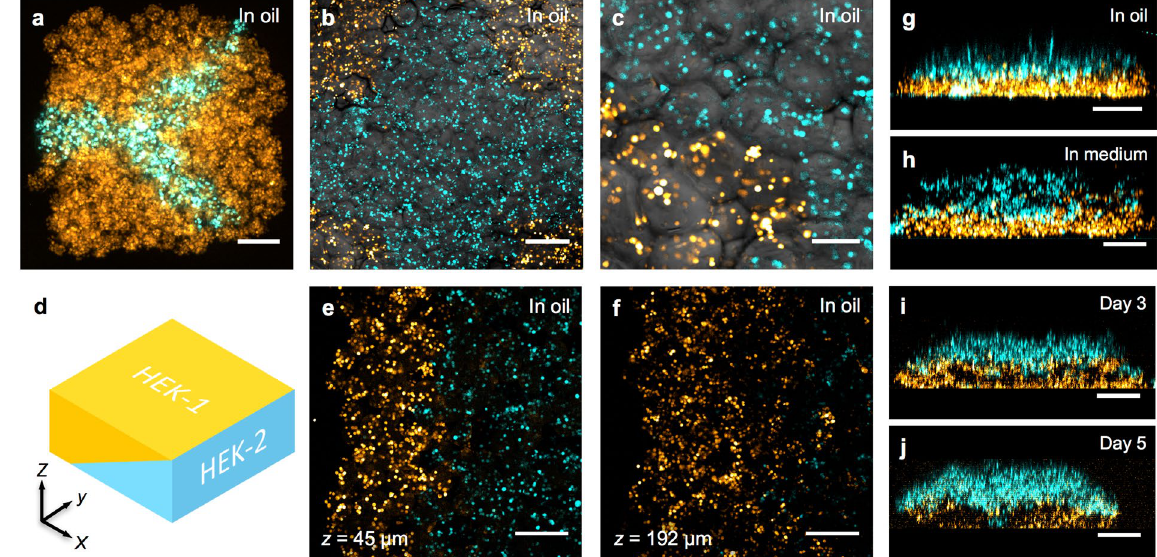
Figure 2. High-resolution patterning of two cell types. ( a – c, e,f ) Confocal fluorescence micrographs of printed cellular constructs in oil, immediately after printing. HEK-293 cells stained with Deep Red (DR) or Red CMPTX (RC) CellTracker ™ dyes were false-coloured blue and yellow, respectively. ( a ) A Y-shaped structure within a square construct (8 × 9 × 4 droplets), with a mean feature width of 180 μ m. (Scale bar = 200 μ m). ( b ) A cruciform pattern of HEK-293 cells within a square construct (10 × 12 × 5 droplets). (Scale bar = 250 μ m). ( c ) A high magnification image of the patterned HEK-293 cells in ( b ). (Scale bar = 100 μ m). ( d ) A 3D model of a cuboidal cellular construct with an interface between two HEK populations (HEK 1, yellow; and HEK 2, cyan) at a diagonal in the x - z plane. ( e,f ) Partial cross-sections at fixed vertical positions (45 and 192 µ m respectively) of a cellular construct (21 × 24 × 7 droplets) printed based according to the model in ( d ), showing both HEK populations. (Scale bars = 250 μ m). ( g – j ) Side-on images of lamellar constructs, comprising CellTracker ™ stained HEK-293 cells before and after phase transfer. The lower, DR-stained HEK-293 cell layers (yellow) were 3 droplets thick, while, the upper, RC-stained HEK-293 cell layers (blue) were 4 droplets thick ( g , h ) or 3 droplets thick ( i , j ). Images were recorded: ( g ) at day 0, in oil, immediately after printing; ( h ) immediately after transfer to culture medium; ( i ) on day 3 of culture, in medium and; ( j ) on day 5 of culture, in medium. (Scale bar = 250 μ